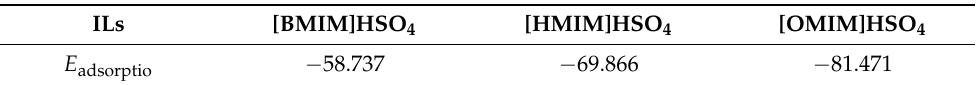
Figure 5. The stable adsorption configurations of [BMIM]HSO 4 , [HMIM]HSO 4 , and [OMIM]HSO 4 (from left to right) inhibitor on Cu (111) obtained by the MD simulations in a vacuum ( top : side view, below : top view). Table 3. Adsorption energies (kcal/mol) of inhibitors on the Cu(111) surface from an MD simulation in a